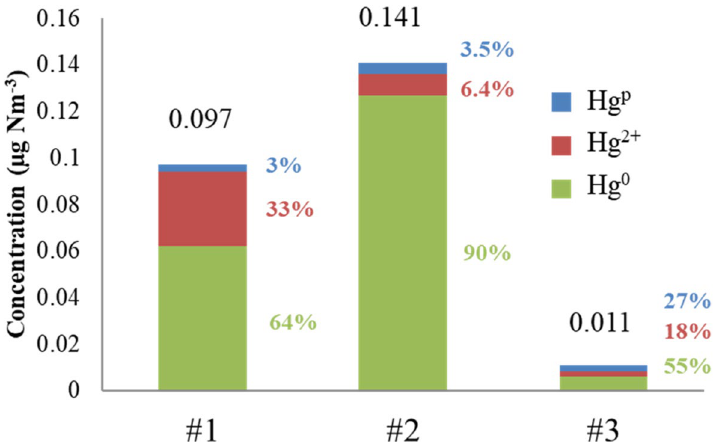
Fig. 2 Concentrations and speciation of mercury in stack gas in campaign